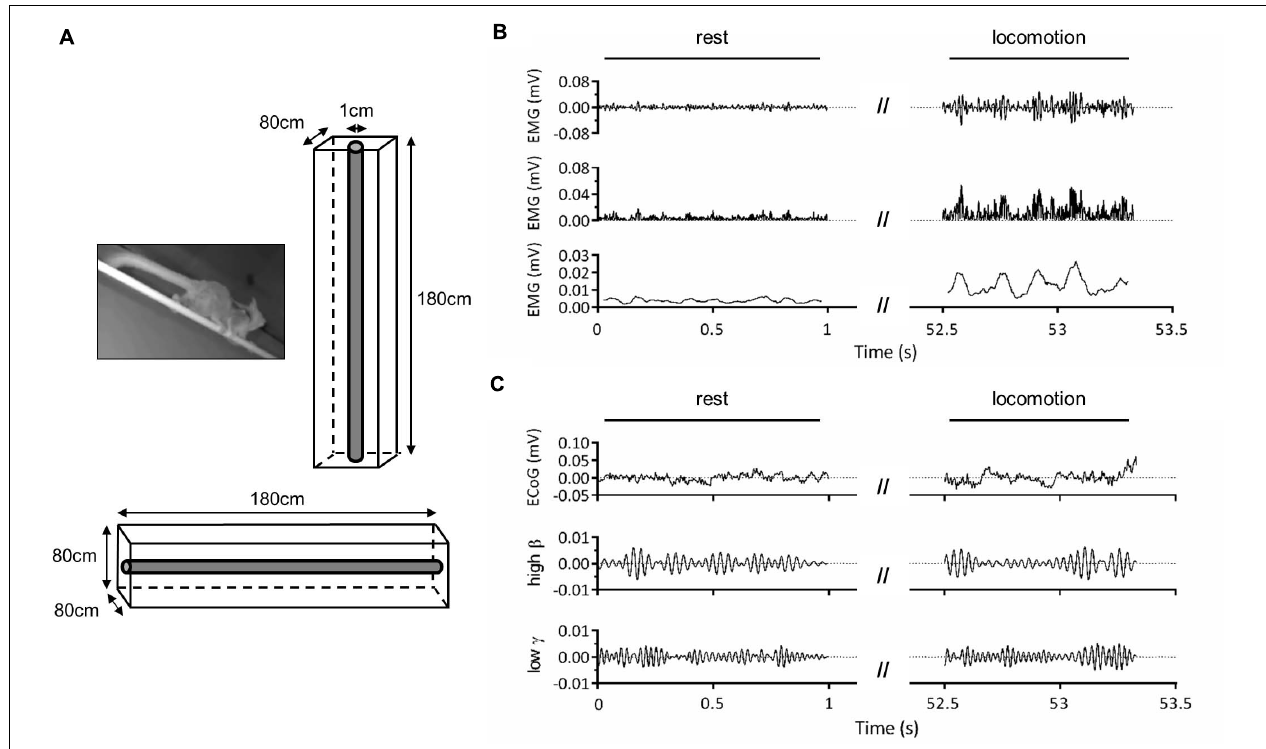
FIGURE 1 | Experimental setup. (A) Adult male mouse lemur moving on a 1-cm diameter wooden pole (left panel) and schema of the experimental cage used for vertical and horizontal locomotion tasks (right and bottom panels). (B) Representative electromyographic (EMG) activity of the right triceps muscle during locomotion on the horizontal substrate. The first panel represents band-pass (30–500 Hz) filtered EMG signal, the second panel shows the rectified signal, and the third panel, the signal obtained after applying a 50-ms moving average to illustrate cyclic muscle contraction during locomotion. (C) Representative electrocorticographic (ECoG) activity of left primary motor cortex during the same trial. The first panel represents the raw signal, the second panel, the high β (25–35 Hz) component and the third panel, the low γ (35–50 Hz) component obtained after band-pass filtering.